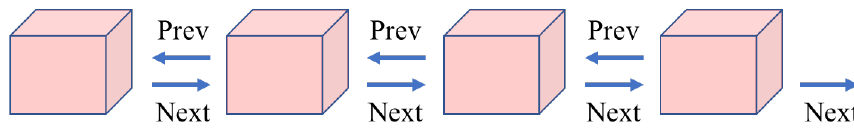
Figure 3. Secondary data structure diagram.